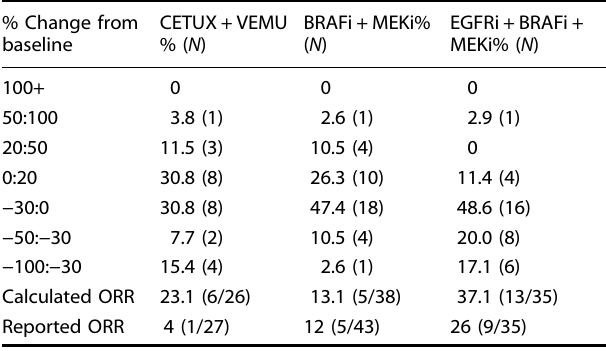
Table 3. Distribution of patient-level tumor response data from published clinical studies in BRAF V600E